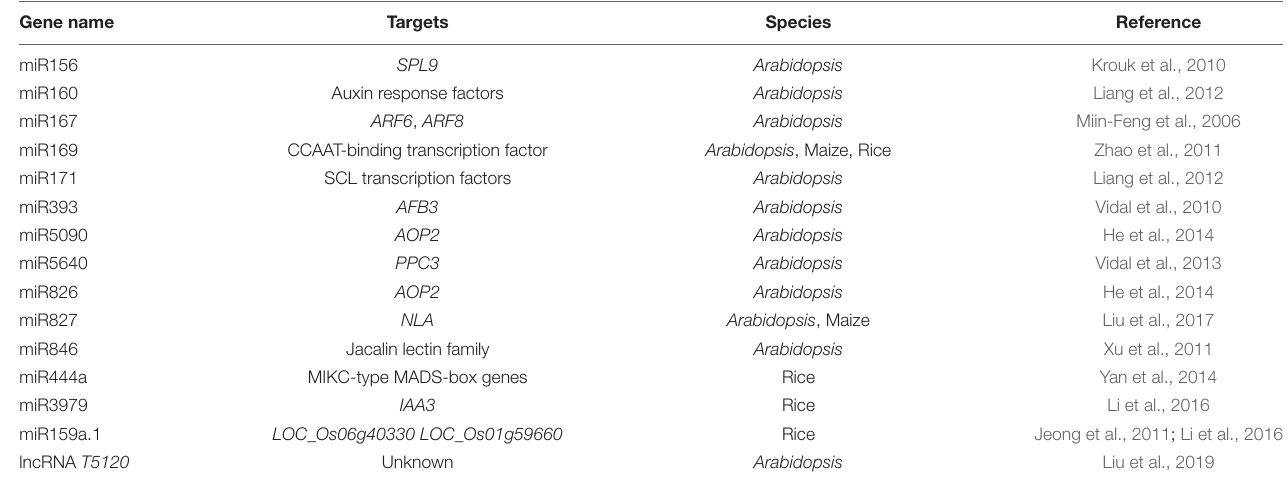
TABLE 1 | Characterized ncRNAs involved in NO 3 −